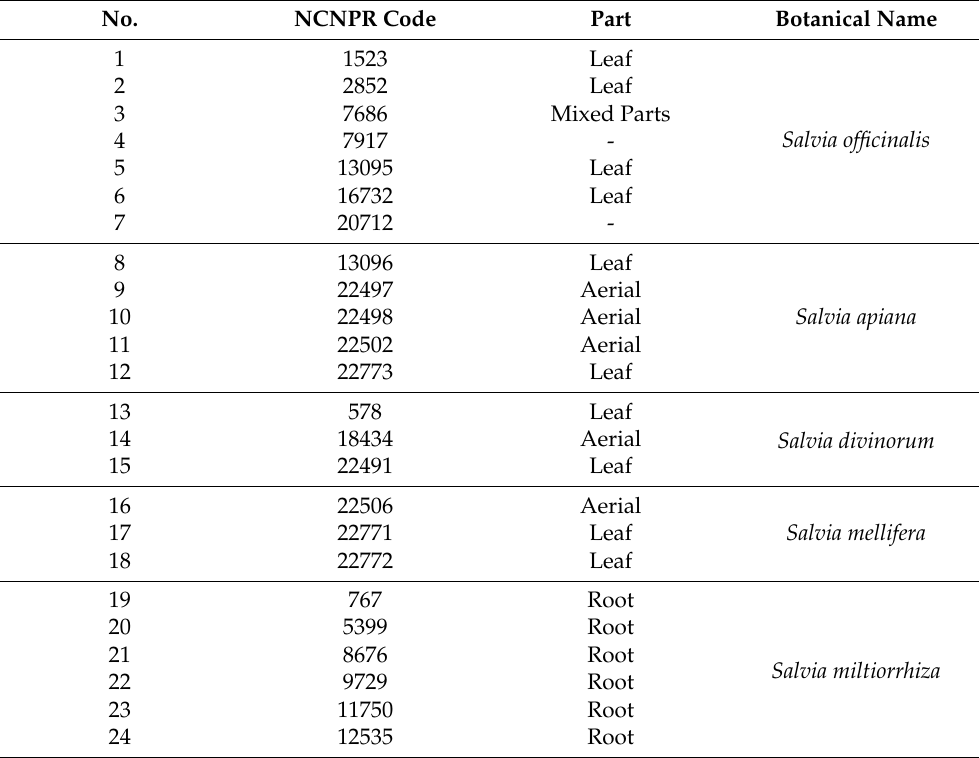
Table 1. Analyzed authenticated Salvia